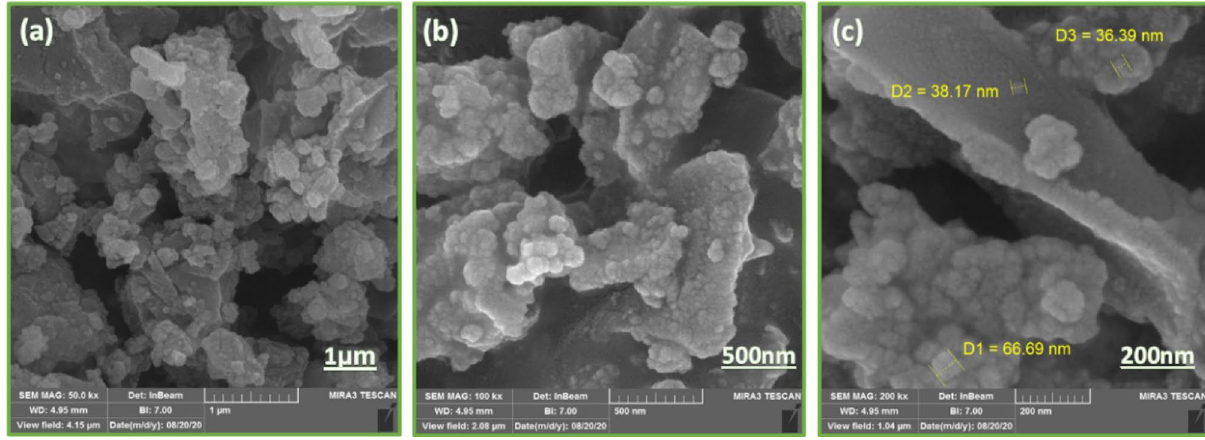
Figure 4. SEM images of β-CD-TSC@Cu.